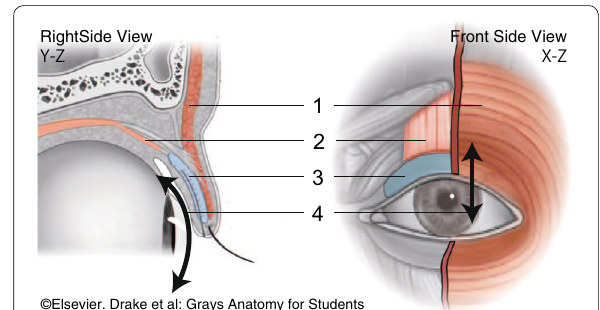
©Elsevier. Drake et al: Grays Anatomy for Students Fig. 2 Eyelid Structure. 1. Orbicularis oculi (sphincter muscle); closes eyelids. 2. Levator muscle of the upper eyelid (striate muscle); opens eyelids. 3. Tarsal plate (connective tissue); contributes to eyelid form and support. 4. Locus of tarsal plate; set as a requirement for eyelid